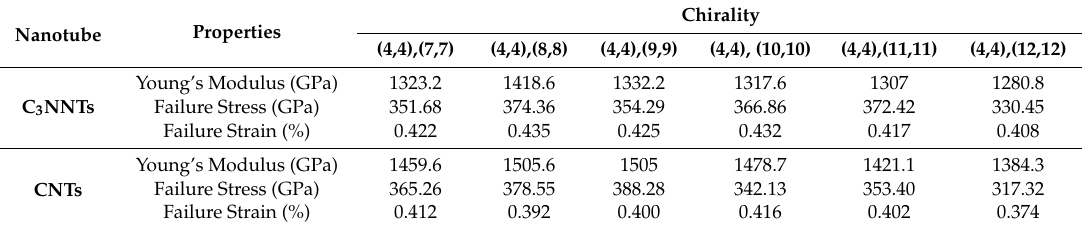
Figure 7. ( a ) Young’s modulus, ( b ) failure stress, and ( c ) failure strain of DWC 3 NNTs and DWCNTs under uniaxial tensile tests as a function of interlayer distance. Table 4. Mechanical properties of armchair DWC 3 NNTs and DWCNTs under uniaxial tensile tests at 300